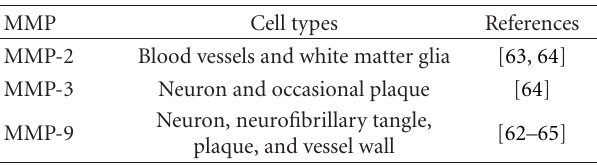
Table 5: MMP protein expression in the brains of patients with Alzheimer’s